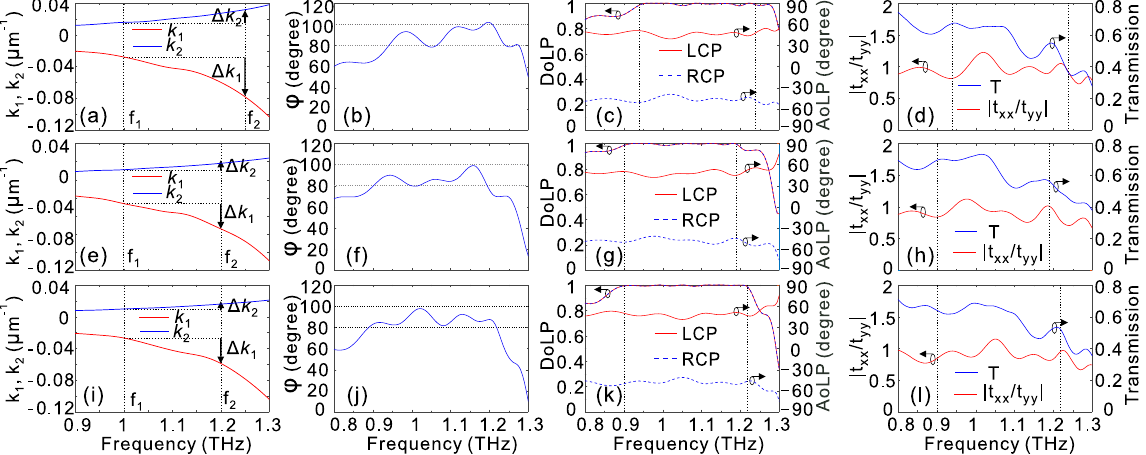
Figure 4. The performance of the three sets of double-stacked HMM waveguide arrays. k 1 and k 2 ( a , e , i ), phase delay ( b , f , j ), DoLP and AoLP with LCP and RCP input ( c , g , k ), and amplitude ratio of t xx / t yy and total transmission T ( d , h , l ) as a function of f for the first ( a – d ), second ( e – h ), and third ( i – l ) double-stacked HMM waveguide arrays: ( a – d )